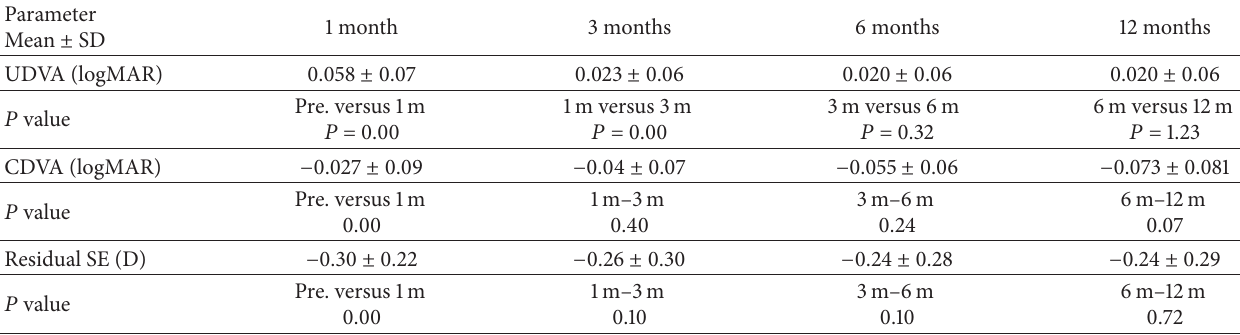
Table 2: Visual acuity and refraction during the complete postoperative follow-up.